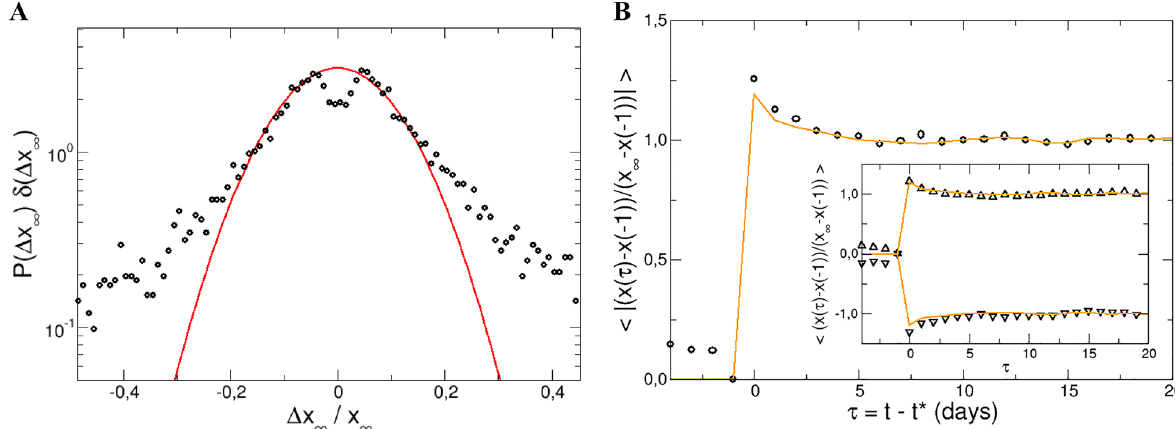
Figure 1. Analysis of events. Left panel ( A ) distribution of the relative total log-price variation (circles), with a Gaussian fitting to the maximum (red line). Right panel ( B ) evolution of the log-price before and after small events in absolute value (circles). The inset shows positive and negative events separatedly. The lines are the prediction from LRT (see text below).